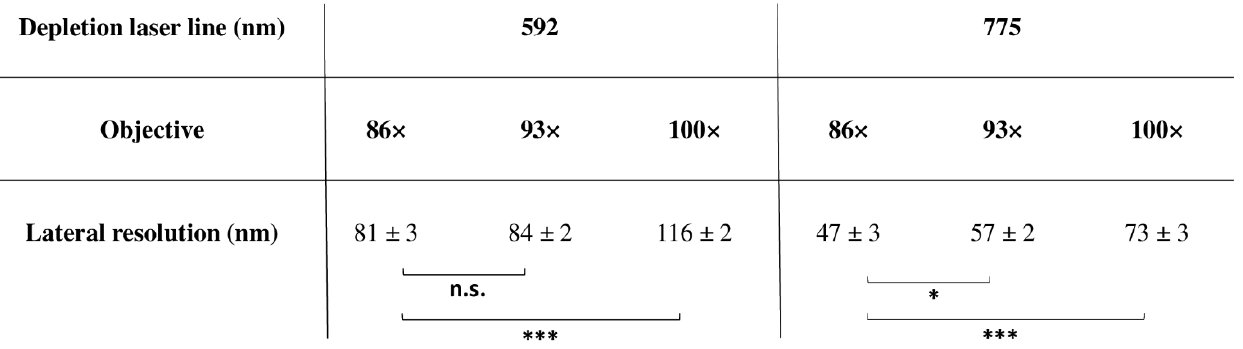
Figure 2. Lateral resolution through 86 × , 93 × and 100 × objectives in stimulated emission depletion (STED) nanoscopy. Fluorescent Yellow-Green and Dark-Red beads (40 nm) were imaged through STED nanoscopy with a 592-nm and 775-nm depletion laser, respectively. Full Width Half Maximum (FWHM) measurement of the bead fluorescence signal with ImageJ led to determination of 86 × , 93 × and 100 × lateral resolution. Each value represents the mean ( ± SEM) of minimum 10 independent experiments. n.s.; * p < 0.05; *** p < 0.001 vs 86× using an ANOVA test followed by a Tukey – Kramer multiple comparison test.